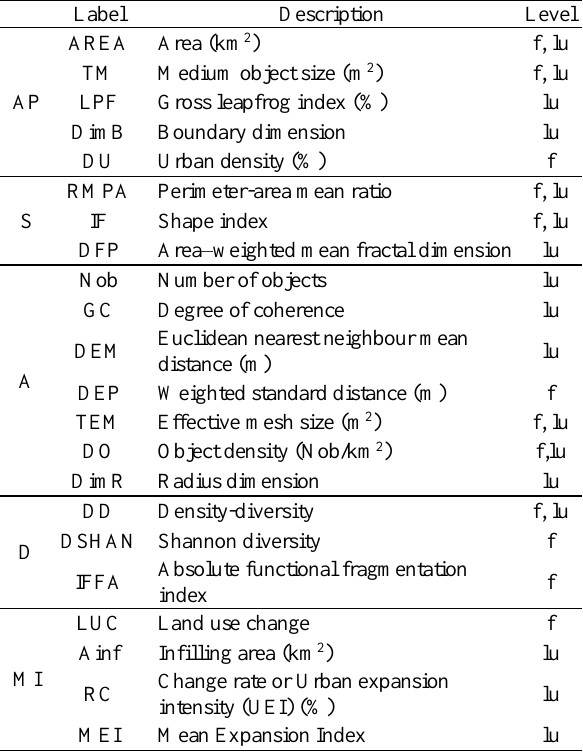
Table 1. Selected fragmentation metrics categorised in groups: (D), and multi-temporal (MI), and their level of application in